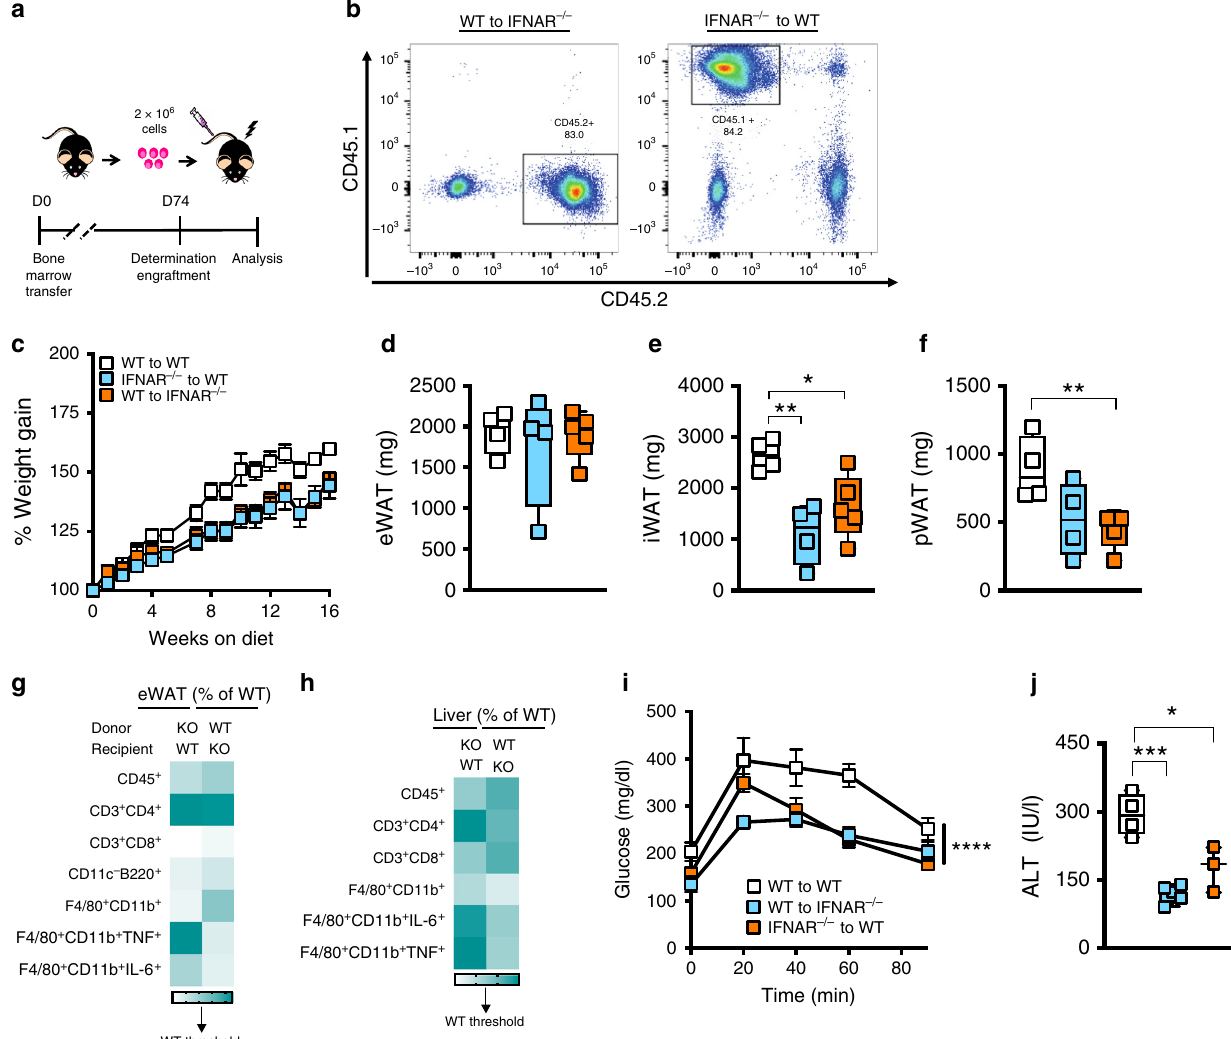
Fig. 5 Hematopoietic and nonhematopoietic IFNAR expression contribute to the pathogenesis of obesity-associated sequelae. Reciprocal bone marrow transfers (BMT) between WT (CD45.2) and IFNAR − / − (CD45.1) mice were performed and successful reconstitution was con fi rmed at d74 post-transfer by fl ow cytometry. Reconstituted mice were place on HFD for 18 weeks. a Schematic diagram of reciprocal BMT. b Reconstitution analysis by fl ow cytometry. c % weight gain over time. d eWAT, e iWAT, f pWAT weights. g Average eWAT immune cell in fi ltration measured by fl ow cytometry; % change over WT. h Average liver immune cell in fi ltration measured by fl ow cytometry; % change over WT. i Glucose tolerance test. j Systemic ALT quanti fi ed at time of harvest. a − j A single experiment, n = 4 − 5/condition. c , g − i For line graphs and heat maps data represent mean ± SEM. d − f , j For box plots, the midline represents the mean, boxes represent the interquartile range and whiskers show the full range of values. d − h , j Unpaired